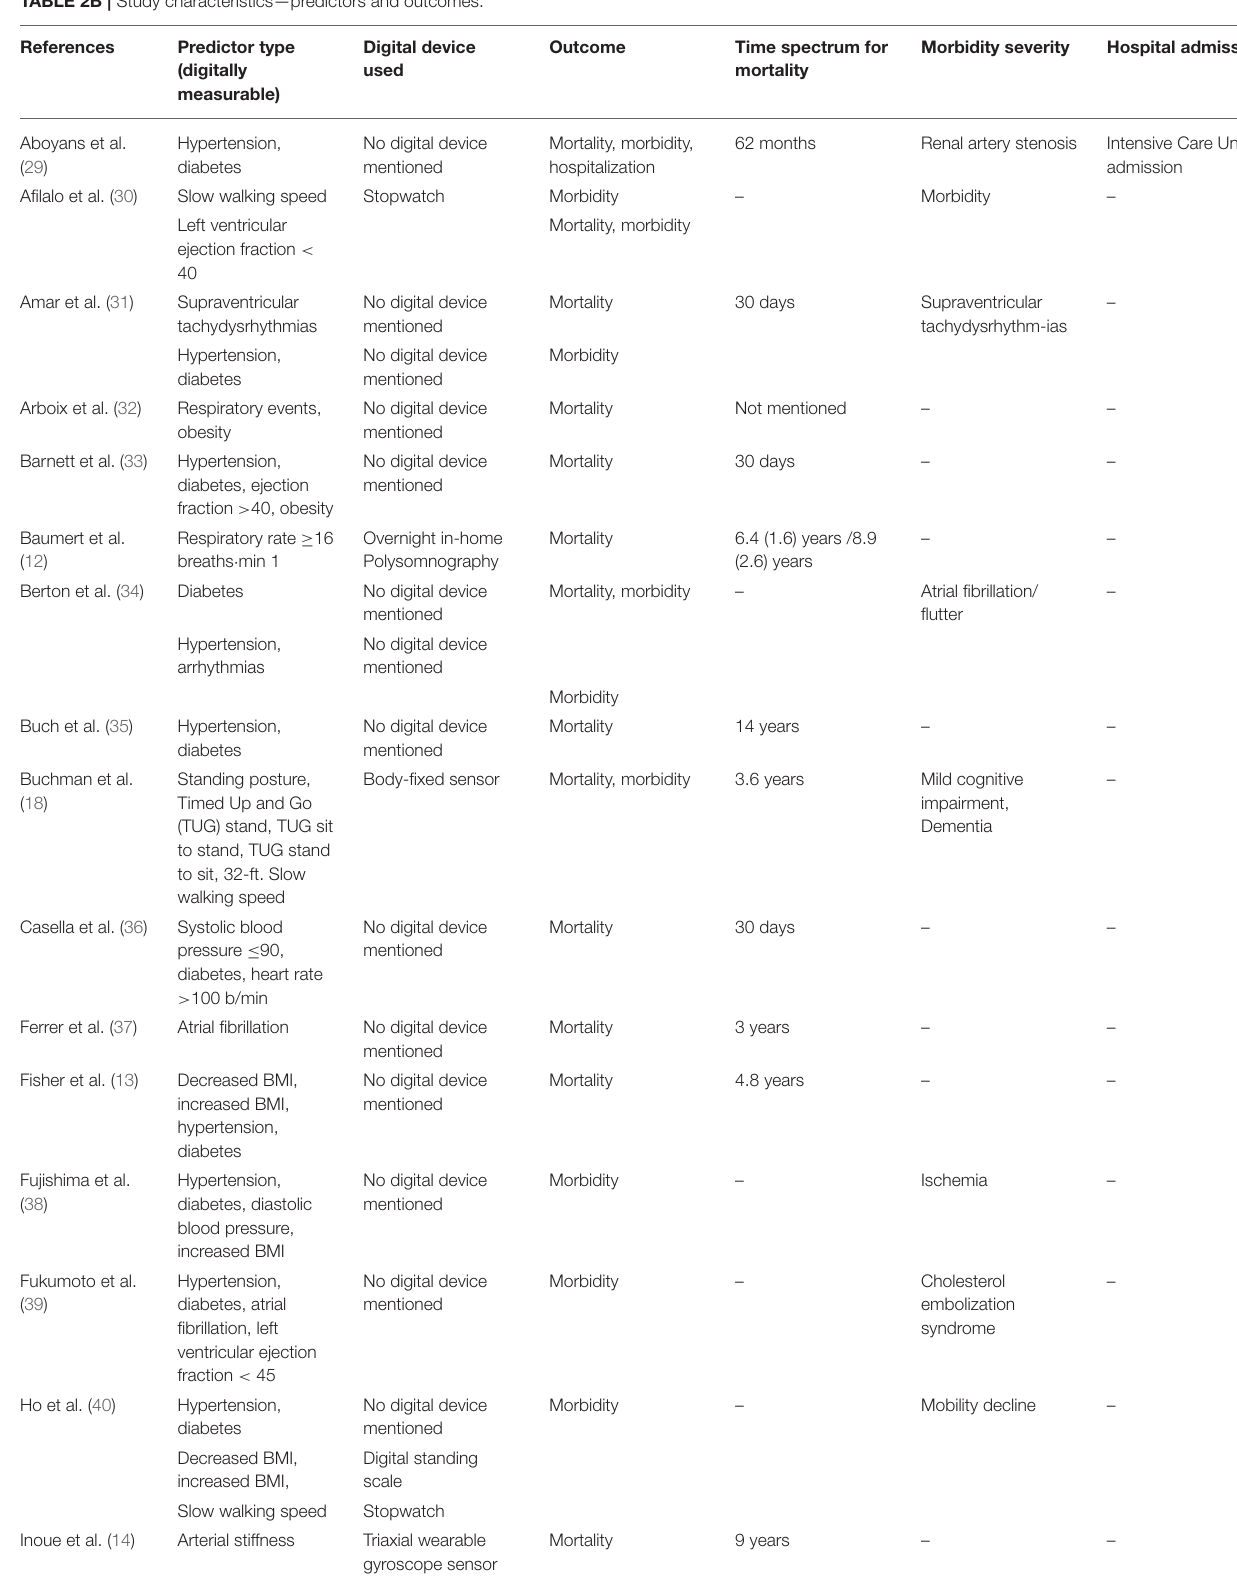
TABLE 2B | Study characteristics—predictors and